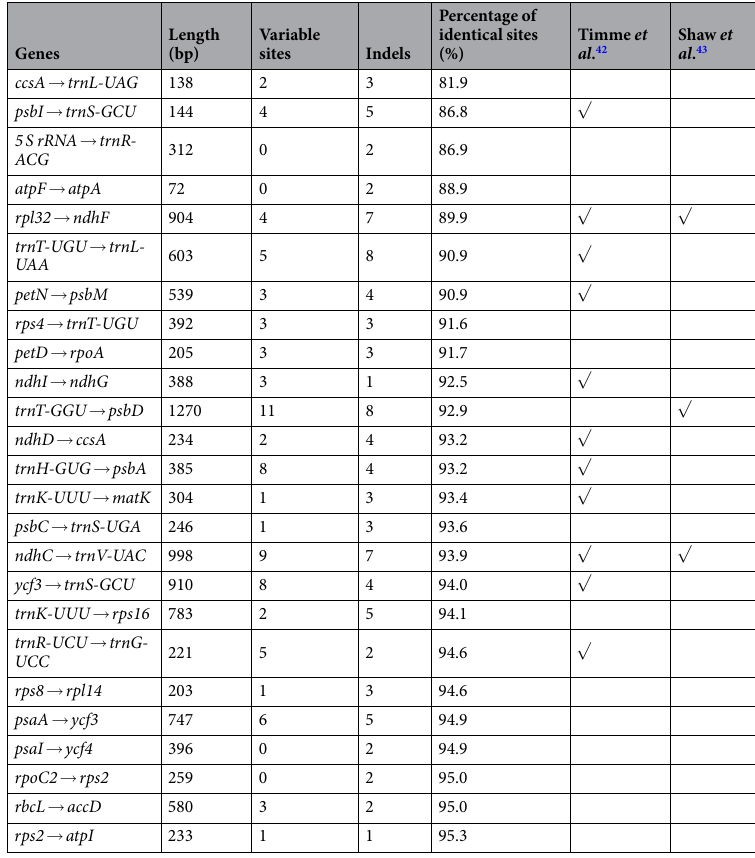
Table 4. The 25 most-divergent non-coding regions among nine Echinacea